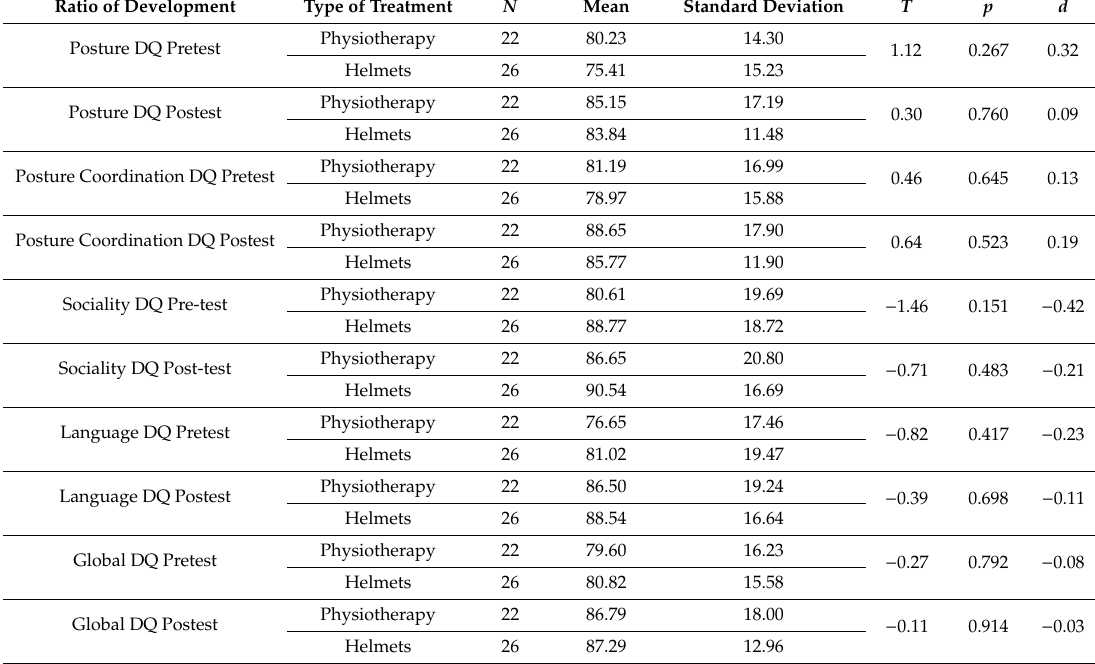
Table 1. Scores in the initial and final assessment by the Brunet–Lezine scale depending on the type of